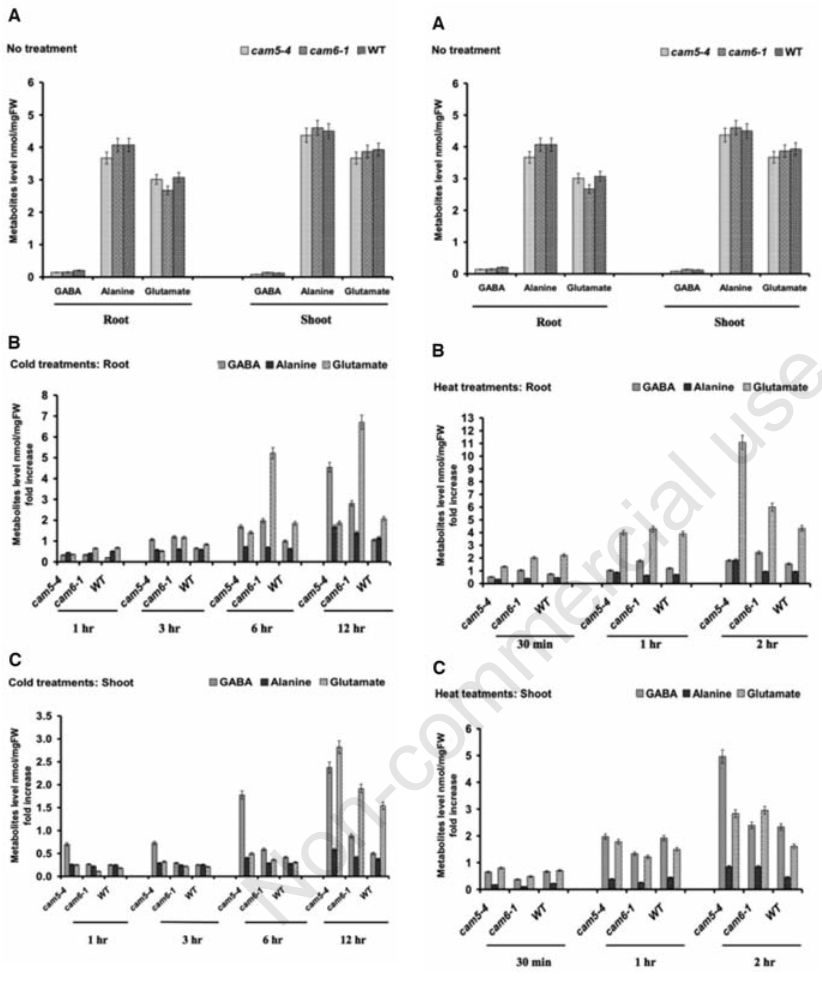
Figure 5. The level of gamma-aminobu- tyric acid, alanine and glutamate in root and shoot tissues of two week old seedlings of wild type and cam mutants of A. thaliana was determined after exposure to cold as indicated. Seedlings were treated for 0 hour, 1 hours, 3 hours, 6 hours and 12 hours at 4ºC. Root and shoot tissues were harvested separately and frozen in liq- uid nitrogen for determination of metabo- lite levels as described in Materials and Methods. Metabolite levels were deter- mined and expressed as nmol/mgFW fold increase. A) No treatment; B) Root; C) Shoot. Error bars represent standard devi- ation over three replicate plates, each con- taining 50 seedlings each of wild type and cam mutants.